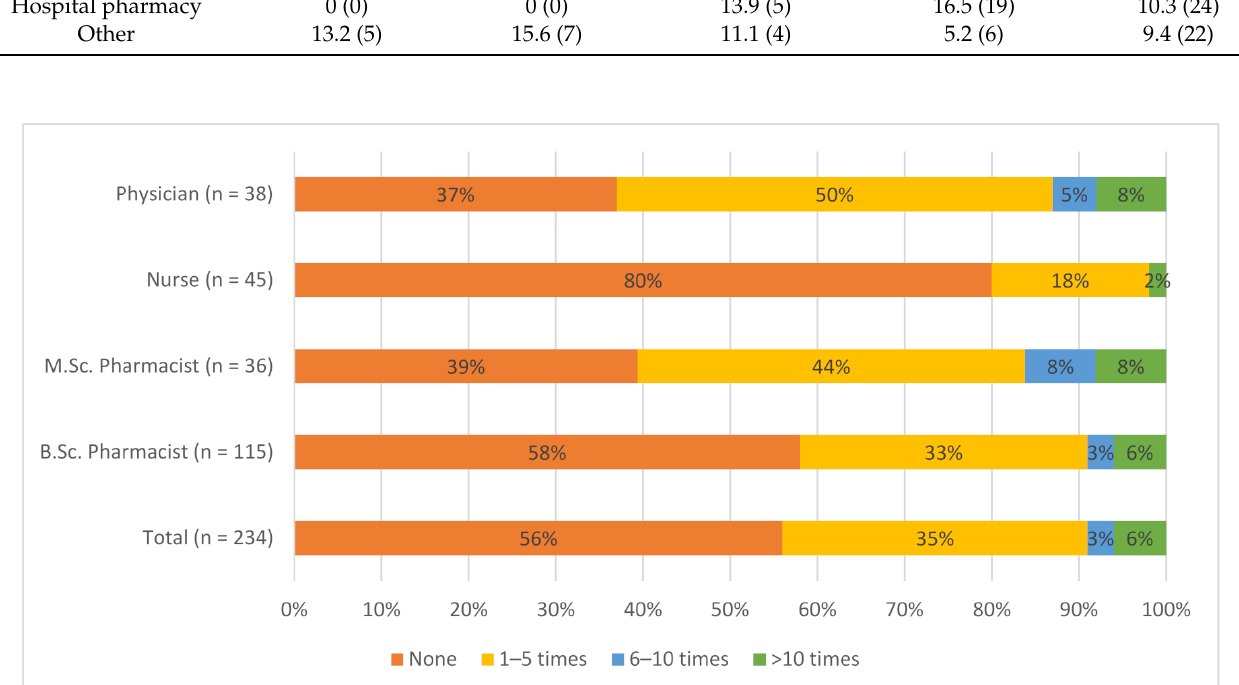
Figure 1. Adverse event reporting experience among healthcare professionals. Questionnaire question: How many times have you reported an adverse event to the local health authority (Fimea) or to the marketing authorization